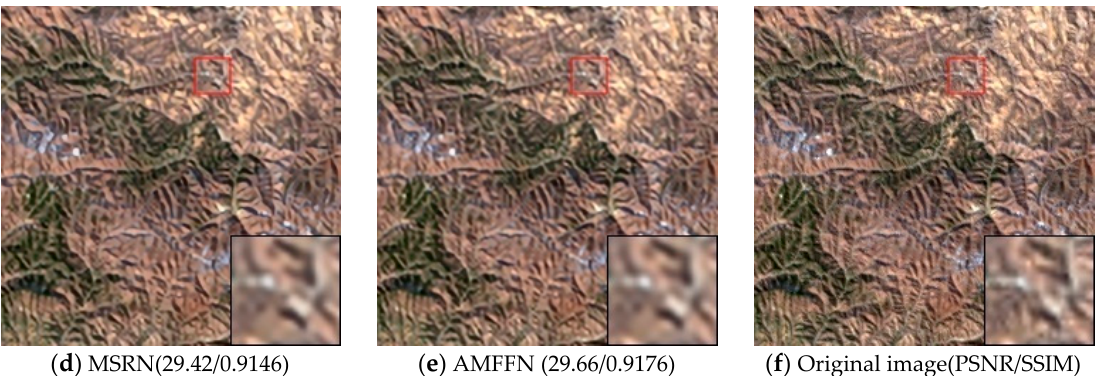
Figure 11. Results of mountain scenes in TG dataset of different methods with scale factor ×2.